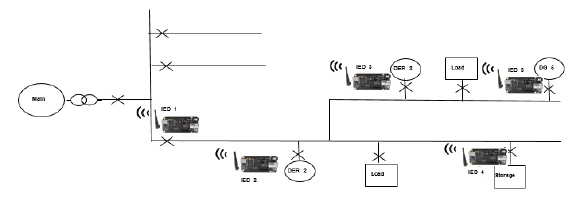
Figure 5: Power system with APN GSM wireless communication network